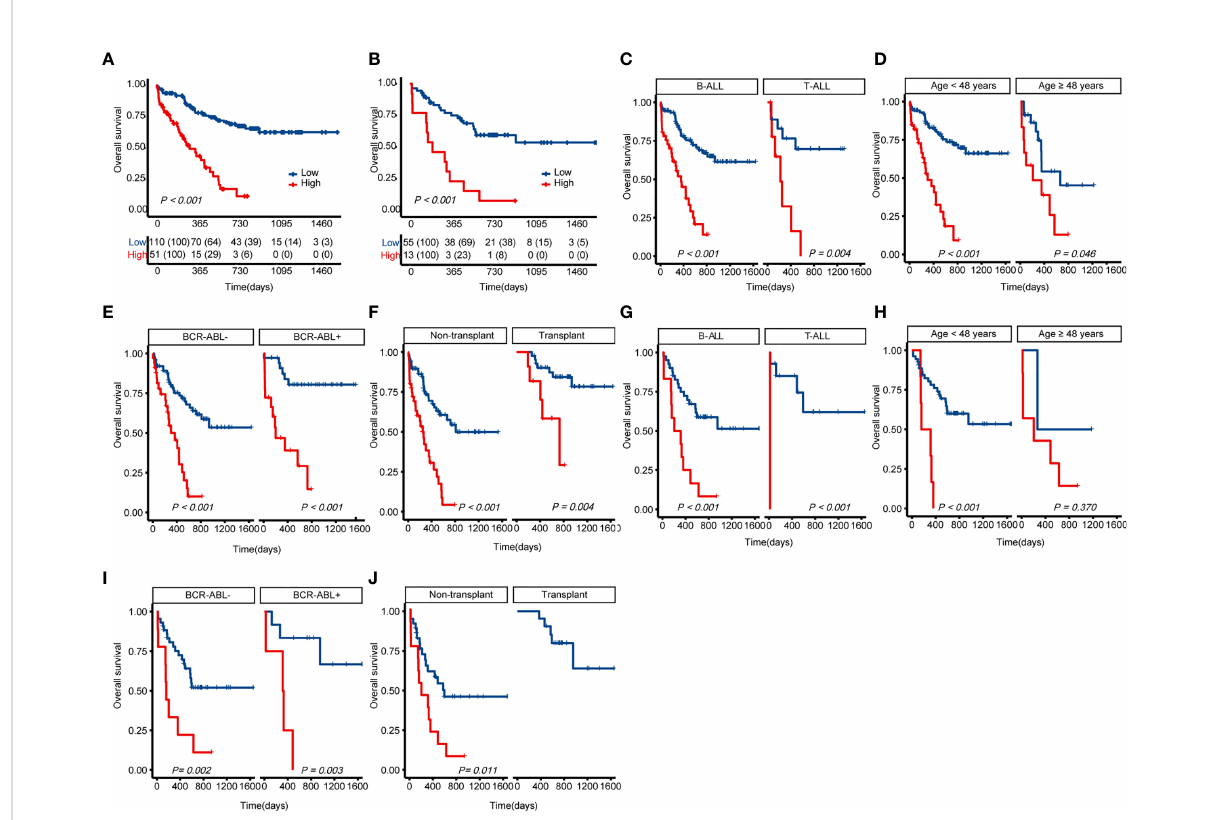
FIGURE 4 Kaplan-Meier curves for overall survival based on the predicted risk score of ALL patients. (A) OS of the training cohort. (B) OS of the validation cohort. (C) Differences in OS between T-ALL and B-ALL groups in the training cohort. (D) Differences in OS between age subgroup in the training cohort. (E) Differences in OS between ph+/- subgroup in the training cohort. (F) Differences in OS between the transplant and non- transplant groups in the training cohort. (G) Differences in OS between T-ALL and B-ALL groups in the validation cohort. (H) Differences in OS between age subgroup in the validation cohort. (I) Differences in OS between ph+/- subgroup in the validation cohort. (J) Differences in OS between the transplant and non-transplant groups in the validation cohort. The P -value for Kaplan-Meier curves is calculated by the log-rank test. OS, overall